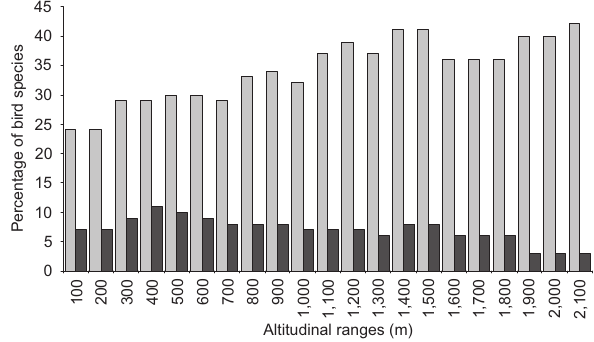
Figure 3. Percentage of bird species endemic to the Atlantic forest (gray bars) and threatened species in the state of Rio de Janeiro (dark bars) for each altitudinal range in the Serra dos Órgãos, south- eastern